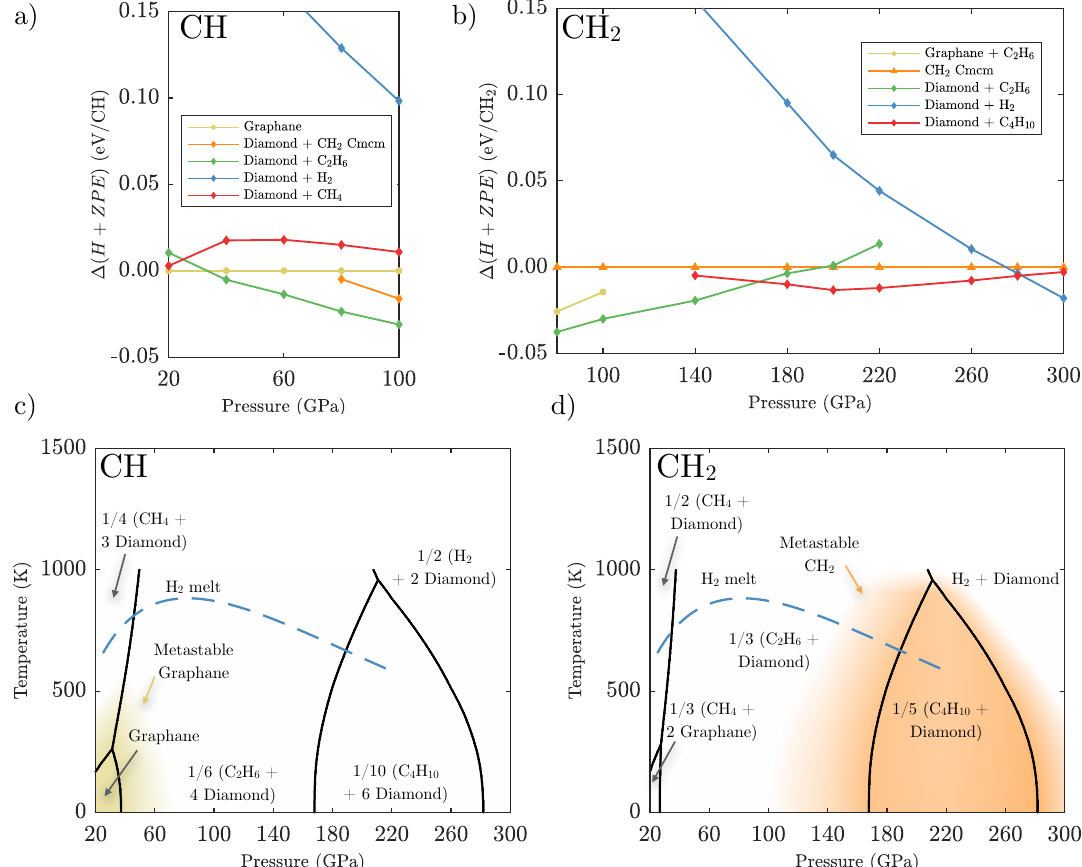
Figure 9. Upper panel : zero temperature free energies including ZPE calculated for relevant phases and mixtures of ( a ) CH composition relative to graphane, and ( b ) CH 2 composition relative to CH 2 - Cmcm . Lower panel : pressure-temperature phase diagrams for ( c ) CH and ( d ) CH 2 calculated using the harmonic approximation. Black lines indicate predicted transitions between labelled phases, the blue dashed line indicates the H 2 melt line as calculated by Bonev et al. [61]. Shaded coloured areas represent the metastability region (within 10 meV/atom) of both graphane and